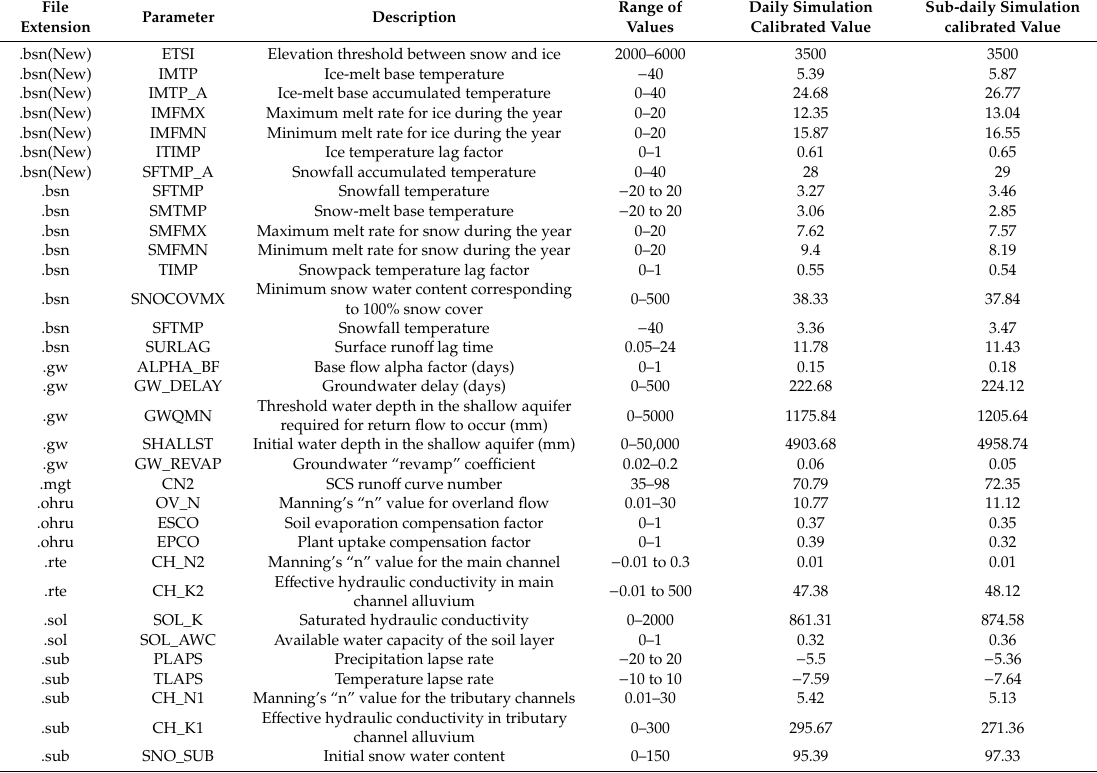
Table 4. Important parameters in the model calibration